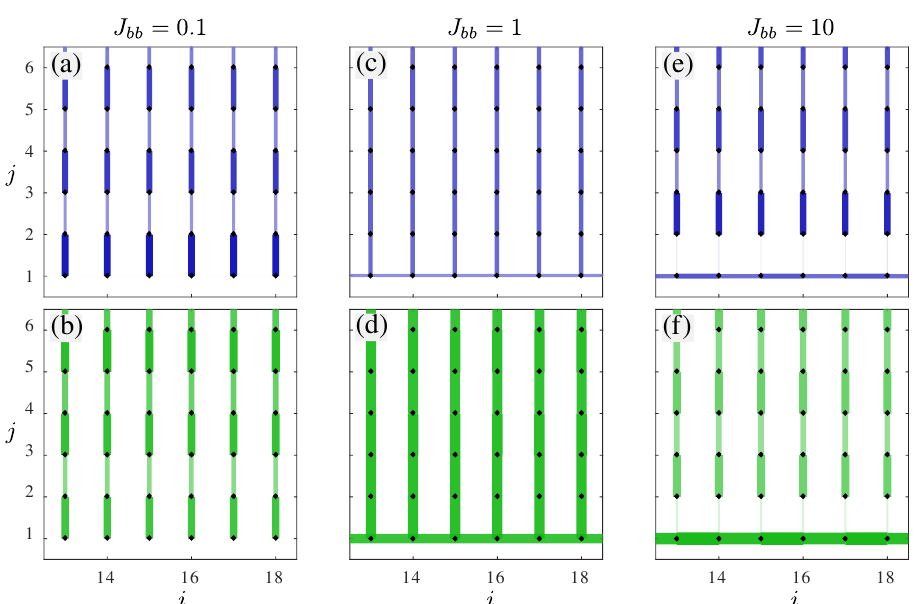
Figure 2: (Color online) Nearest-neighbor spin-spin correlations (upper panels) and the entanglement entropy (lower panels) on a comb lattice with various coupling constants on a backbone. Only a small part in the middle of the backbone of a comb with 30 × 30 sites is shown. The width of the lines and the intensity of the color are proportional to the strength of the correlation (upper panels, blue) or entanglement (lower panels, green).